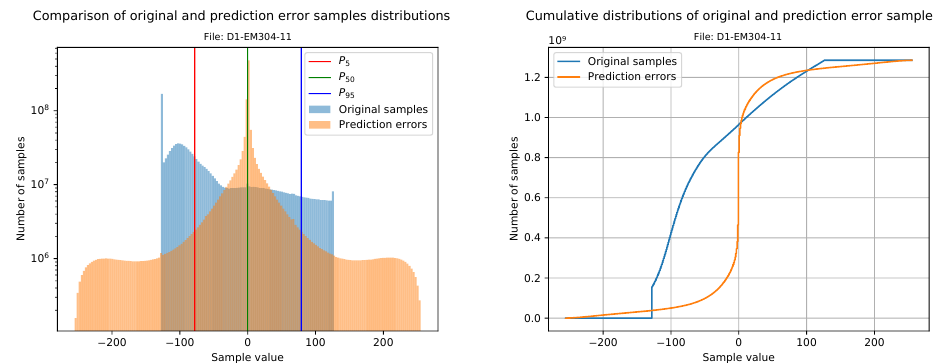
Figure 17. Histograms showing the range reduction in water column data from an